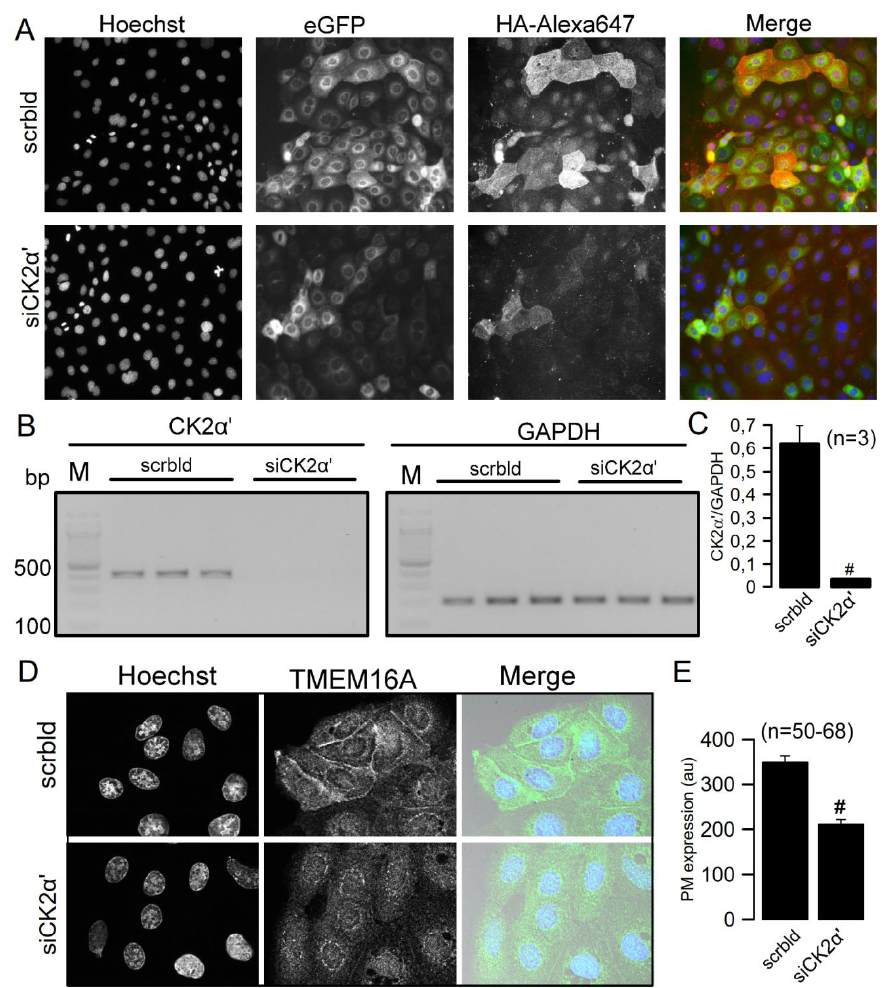
Figure 1. CK2 controls membrane expression of TMEM16A in CFBE airway epithelial cells . ( A